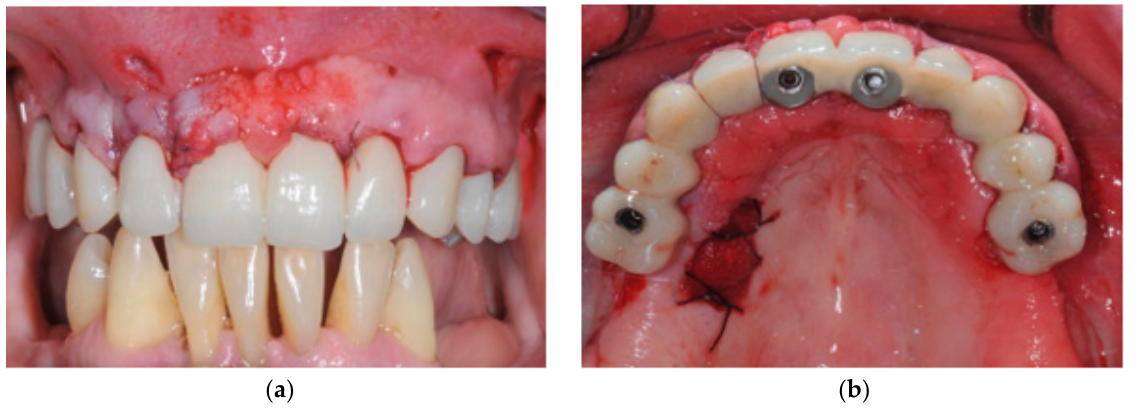
Figure 5. PMMA-reinforced temporary prosthesis: ( a ) frontal view and ( b ) occlusal view. After 4 months, an additional connective tissue graft was needed to improve soft tissue thickness and to better condition and shape the gingival margin in correspondence of the left lateral incisor intermediate element [18] (Figure 6).